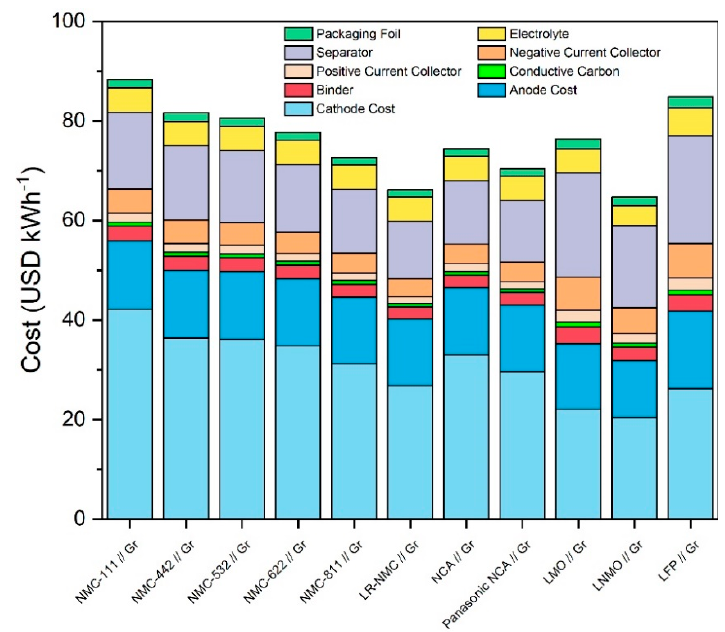
Figure 3. Total material costs of all 10 considered cell chemistries plus Panasonic NCA Use Case differentiated in combined CAM cost, anode cost, and secondary material costs.